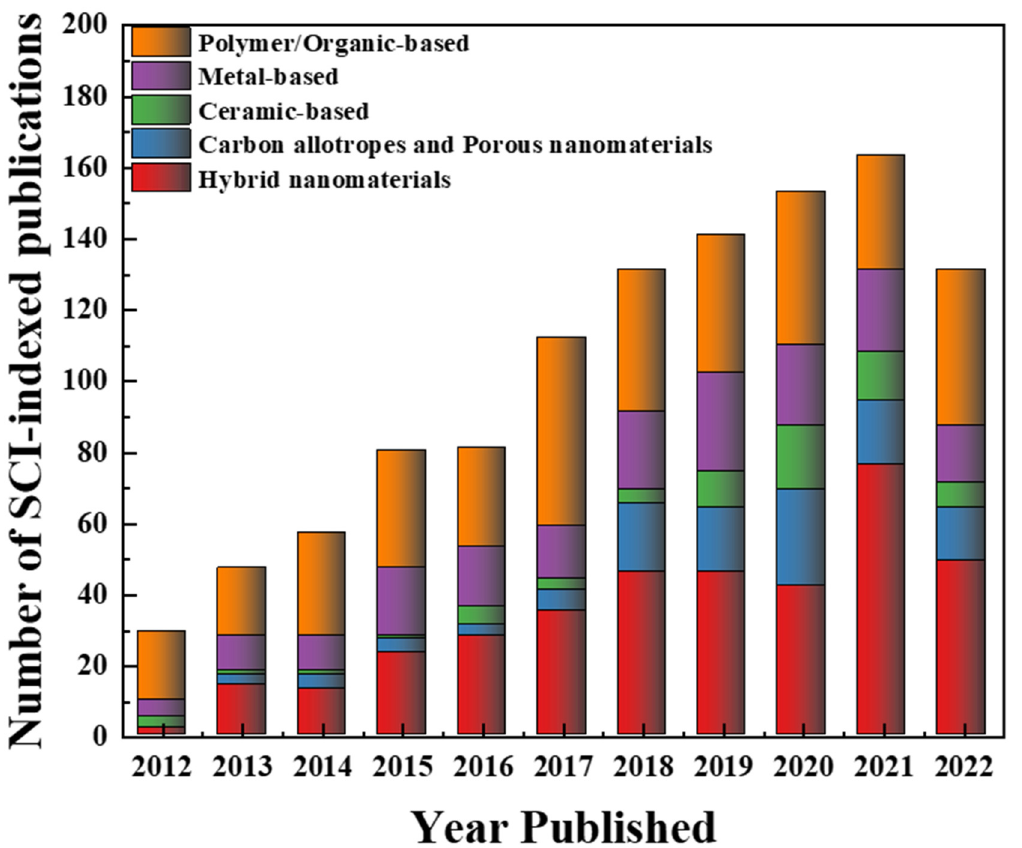
Figure 2. Literature survey of antifouling membranes prepared via blending modification from